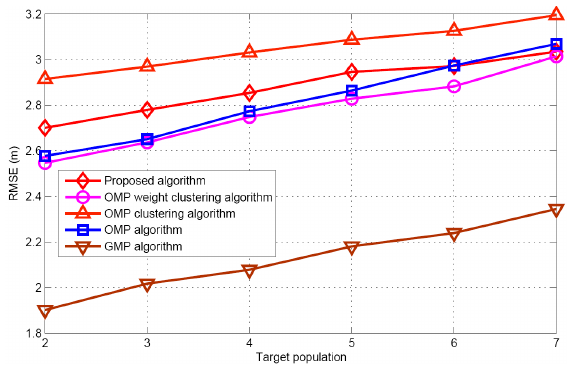
Figure 9. RMSE comparison versus target population.